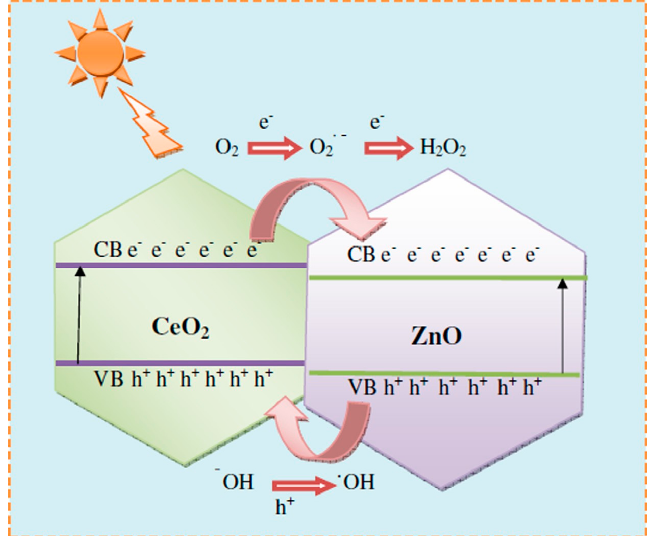
Figure 13. Proposed schematic illustration of photocatalytic activity of the prepared CeO 2 -ZnO hexagonal nanodisk photocatalyst under solar light irradiation. Reproduced with permission from [245]. Copyright Elsevier, 2015.